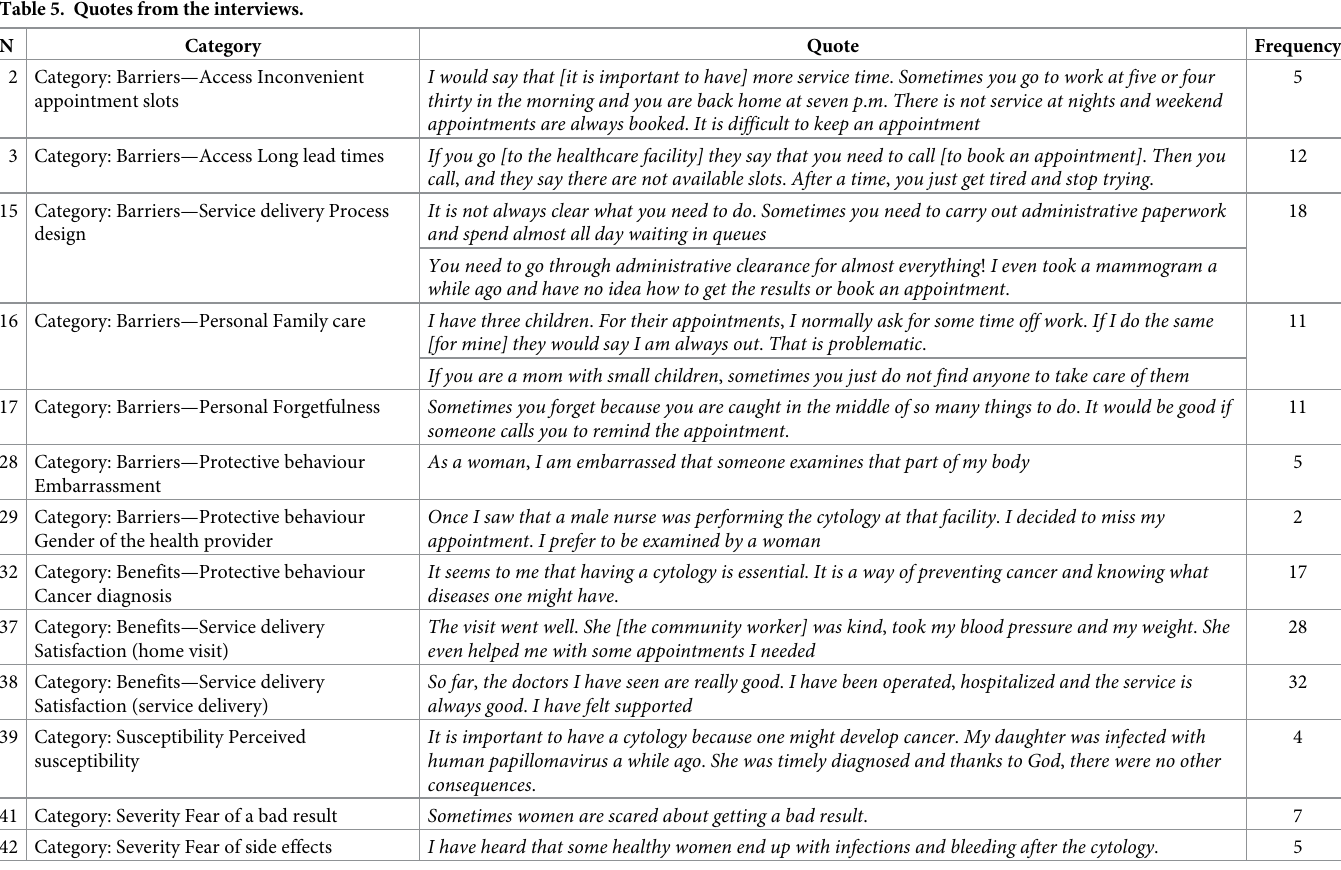
Table 5. Quotes from the